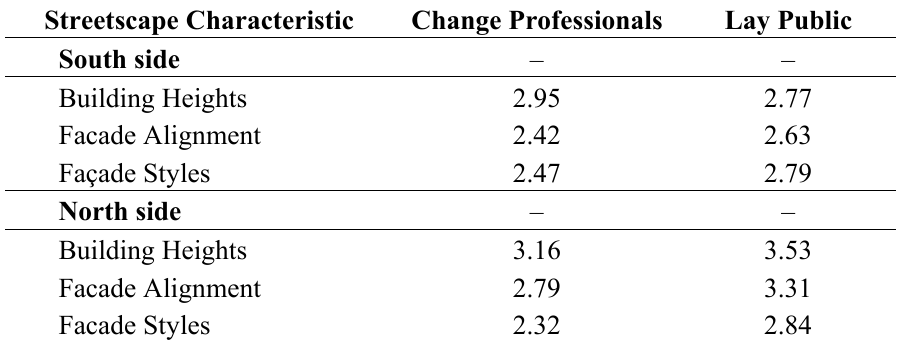
Table 2. Comparison of mean scores for the streetscape characteristics, on 5-point